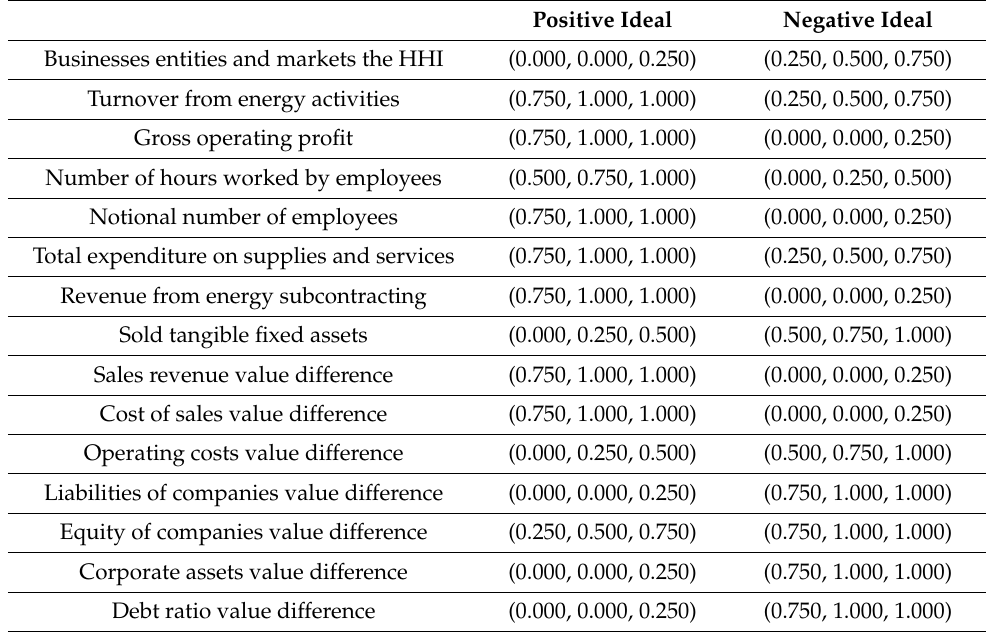
Table 4. Positive and negative ideal solutions of the